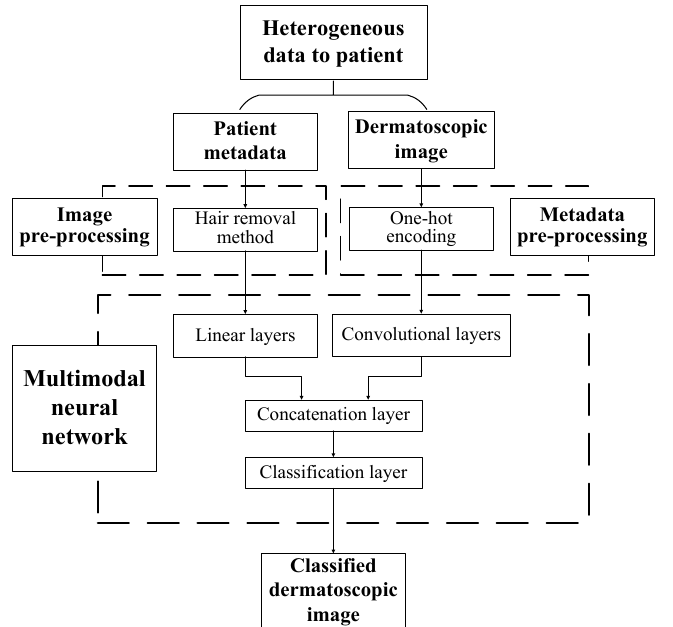
Figure 1. Multimodal neural network system for the classification of dermatoscopic images of pigmented skin lesions with preliminary heterogeneous data processing.